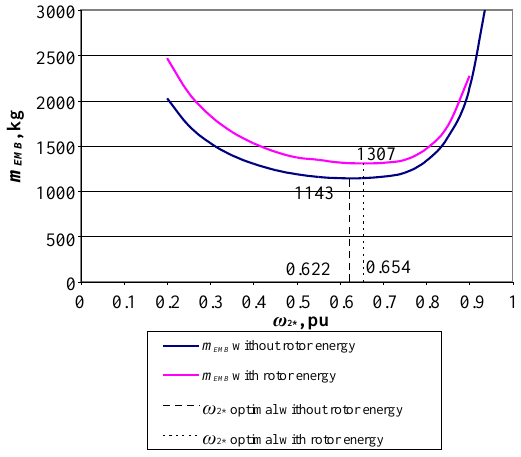
Fig. 4. m EMB curves with and without rotor energy, discharge period 5 s.